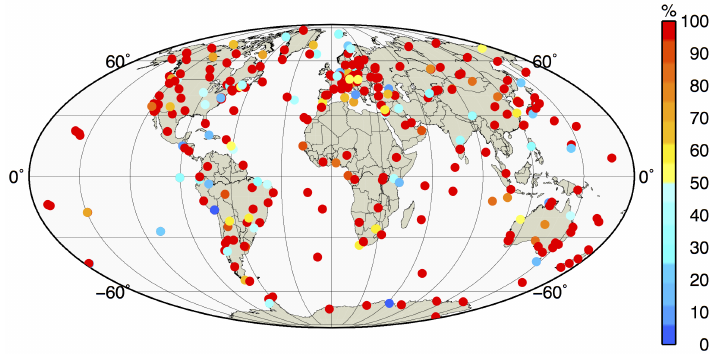
Figure 1. Percentage of the missing surface pressure observations compared to the GNSS-derived ZTD at 371 IGS stations for the period of 2000–2013. Results indicate that no pressure observations are recorded at 67% of stations, and the percentage of missing data is smaller than 25% only at 6% of